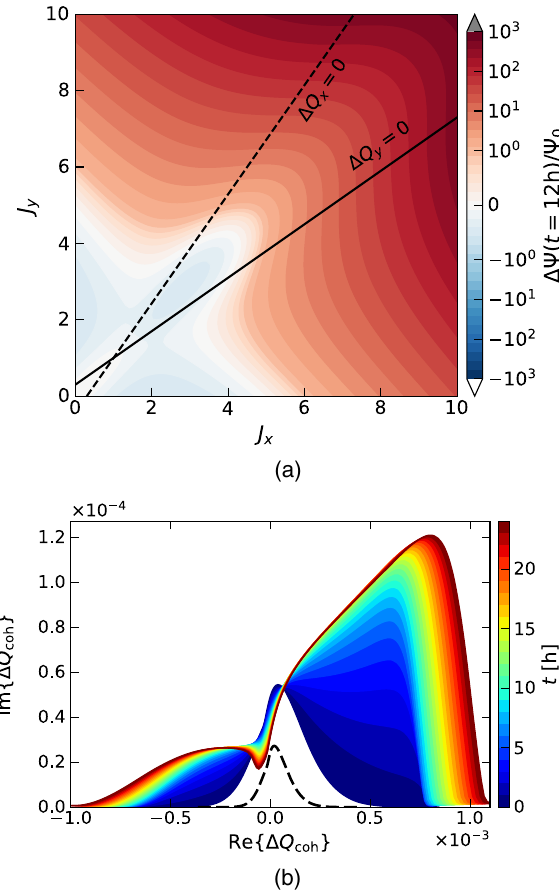
FIG. 6. Evolution with equal noise and detuning in both planes: (a) of the distribution; (b) of the stability diagram. The stability diagram evolves equally in both planes, due to symmetry. The black dashed curve in the stability diagram corresponds to the stability diagram of the initial distribution with half the detuning strength.